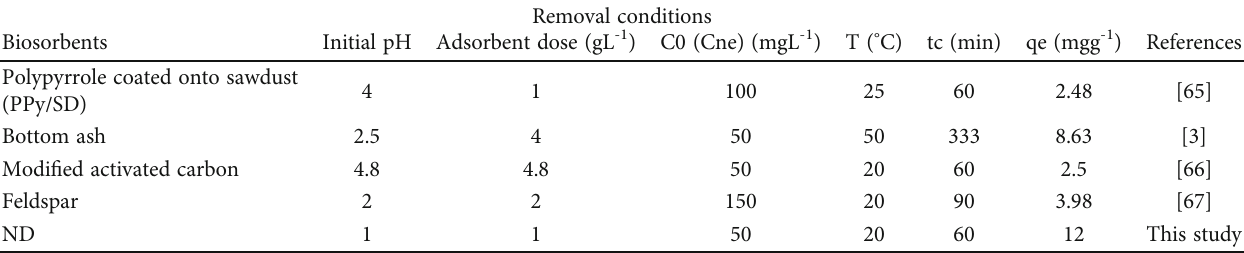
Table 4: Comparison of adsorption capacities of various adsorbents for removal of carmoisine (Cne).